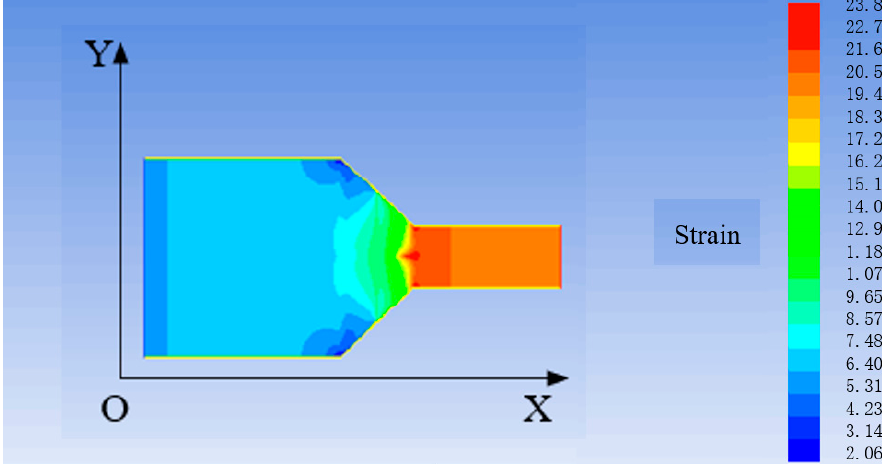
Figure 16. Stress of the venturi (Unit: Pa).